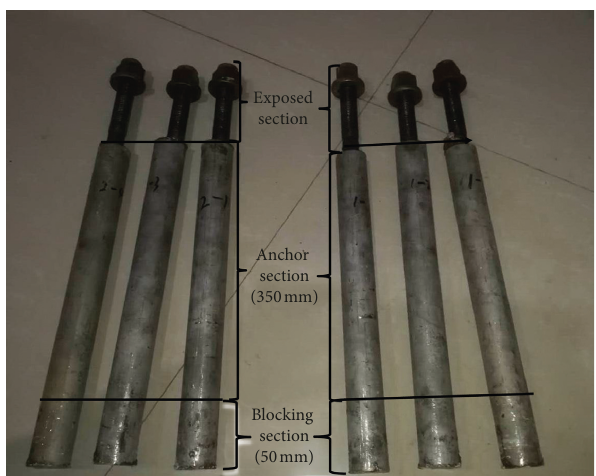
Figure 6: Test pieces for testing anchoring